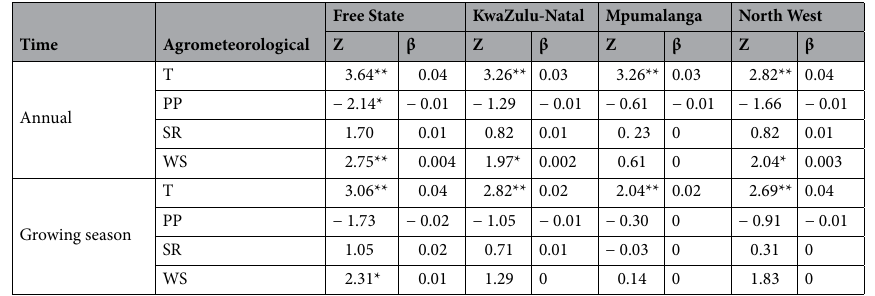
Table 2. Summary statistic of Mann Kendall test (Z) and Sen’s Slope estimator (β) for annual (1990–2020) and maize growing season (1990/91–2020/21). **Significant level at α < 0.01; *significant level at 0.01 < α ≤ 0.05. The beta coefficient (β) indicates changes per year and changes per growing season. See Table 1 for abbreviations of agrometeorological data.